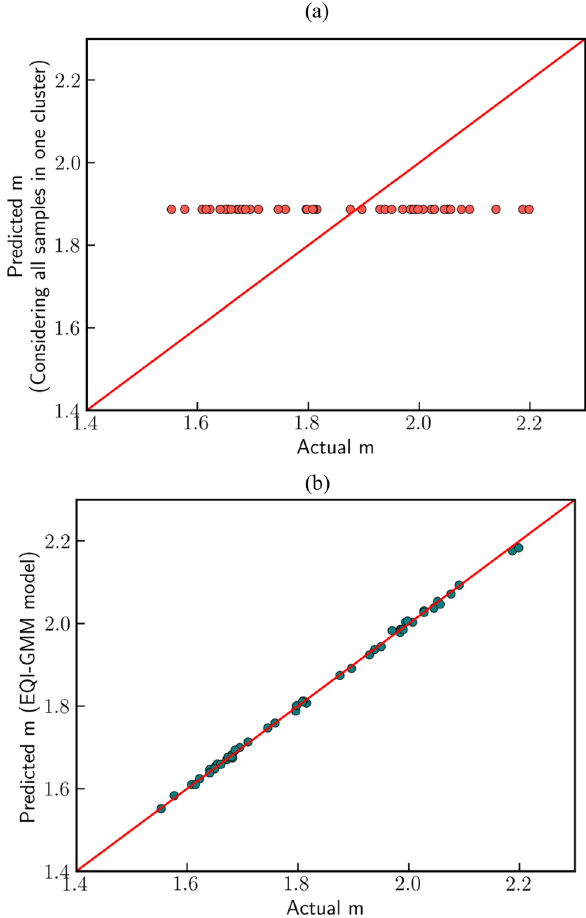
Fig. 9 Cross plot of predicted cementation factor by a Archie’s law and b the proposed EQI-based clustering model versus actual values for testing data from carbonate samples